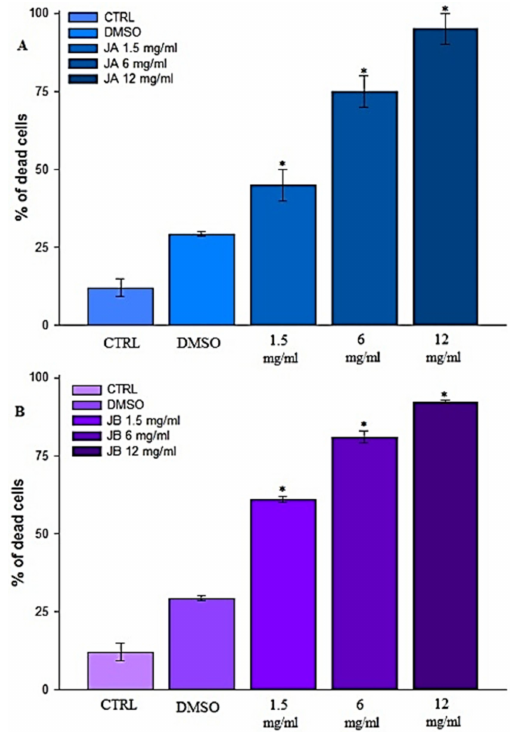
Figure 8. Cytotoxic e ff ect of J. curcas extracts JA ( A ) and JB ( B ) on BRL-3A cells assayed by Trypan blue exclusion assay, after 24 h of treatment. All data are statistically di ff erent from control (* p <